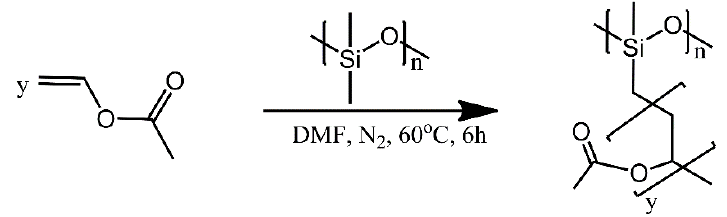
Figure 13. Synthesis of the graft copolymer PDMS-g-PVAc by free radical polymerization. Based on Ref. [35].